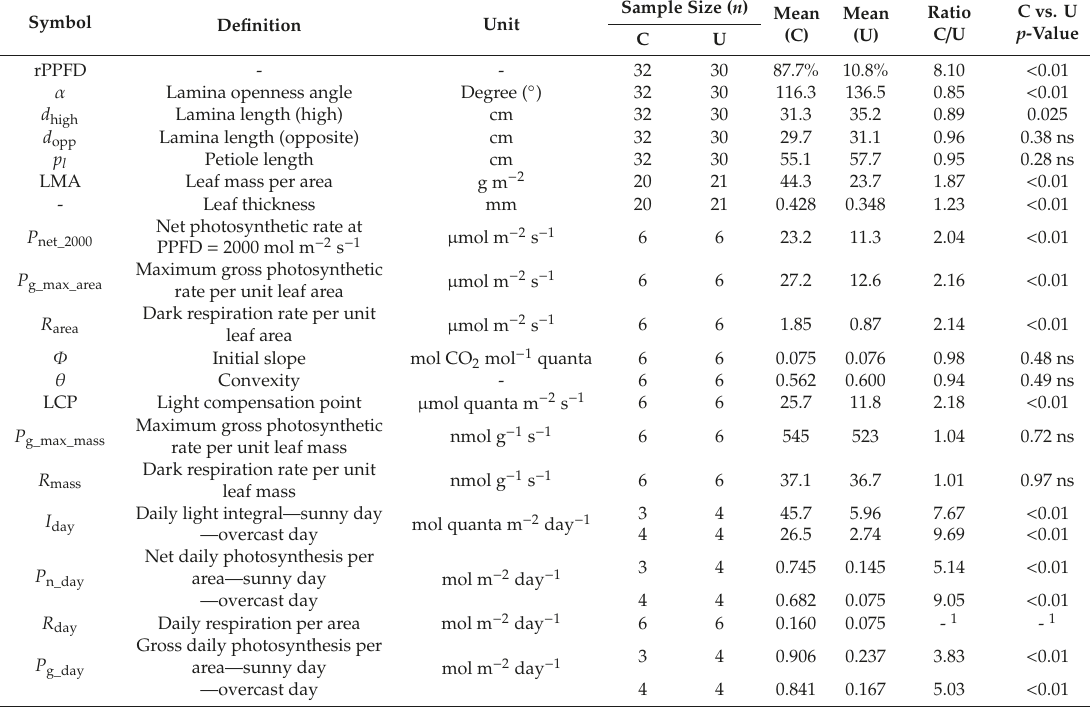
Table 1. Leaf traits in the clearing (C) and in the understory